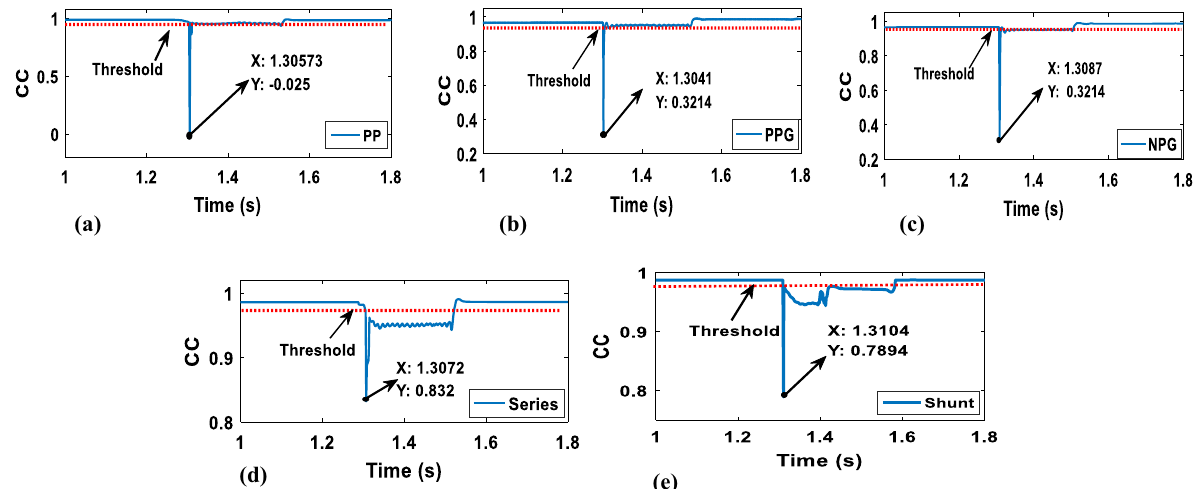
Fig. 14 Fault detection by using SMW-PCC at R f